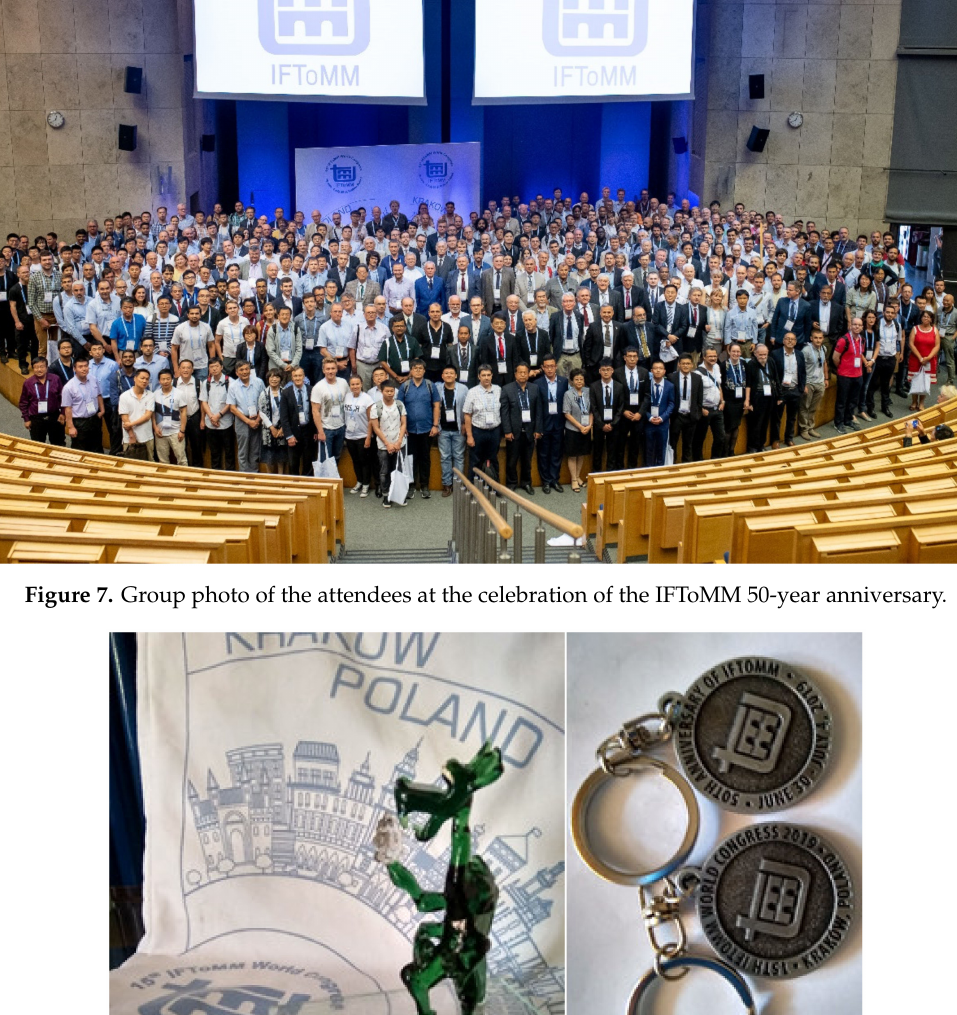
Conflicts of Interest: The authors declare no conflict of